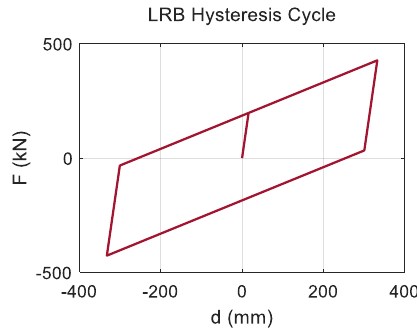
Figure 21. Selected LRB hysteresis cycle.